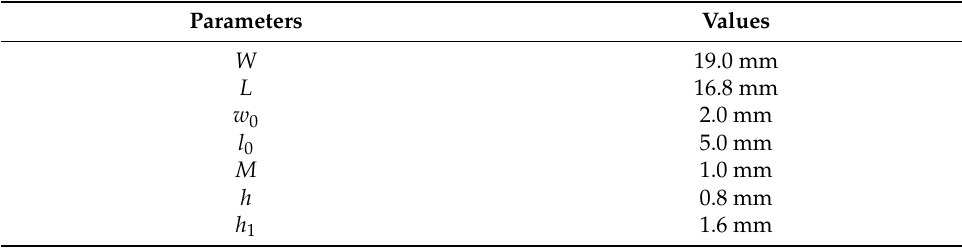
Figure 4. ( a ). Assembly schematic of antenna. ( b ) Top and ( c ) bottom views of the fabricated antenna. Table 1. Dimensions of the antenna array.